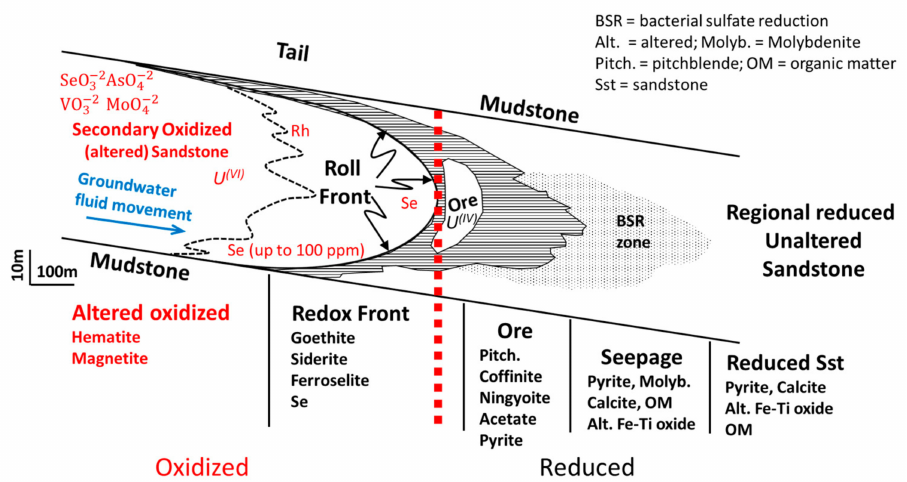
Figure 9. Schematic model cross-section of a typical U roll front deposit with geochemical (Se, Mo, U (IV) , and U (VI) ) and mineralogical distribution throughout redox zones (after